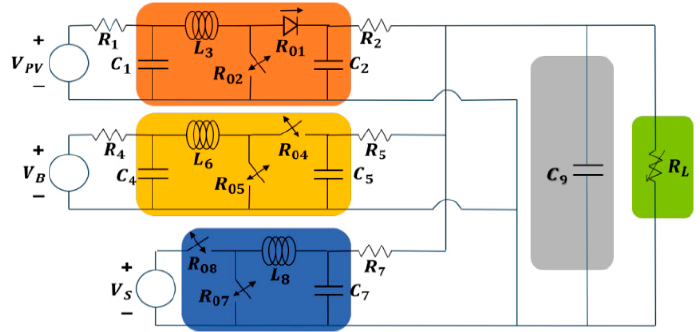
Figure 2. Studied PV-battery islanded dc microgrid configuration.